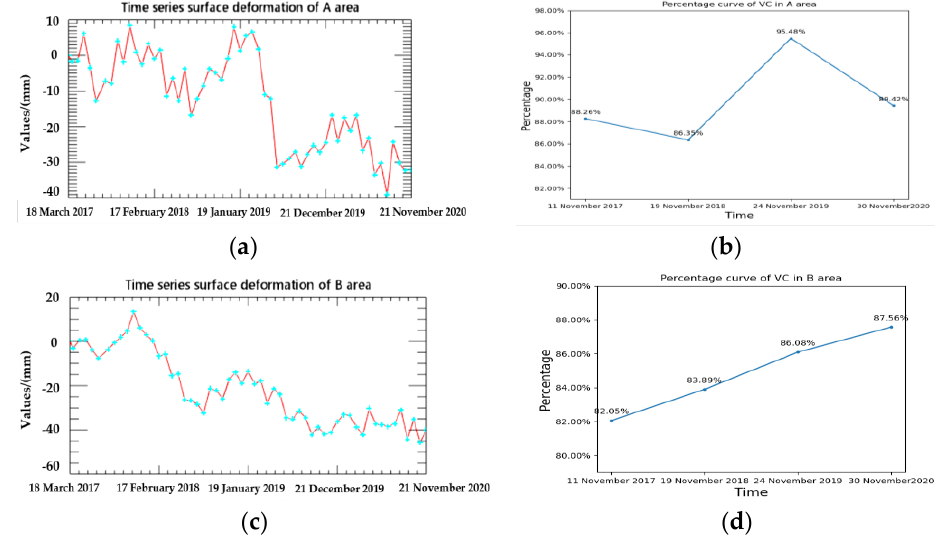
Figure 9. Time series diagrams of the abnormal vegetation information and the surface deformation. ( a ) Time series surface deformation of A area; ( b ) Time series of VC changes in A area; ( c ) Time series surface deformation of B area; ( d ) Time series of VC changes in B area.